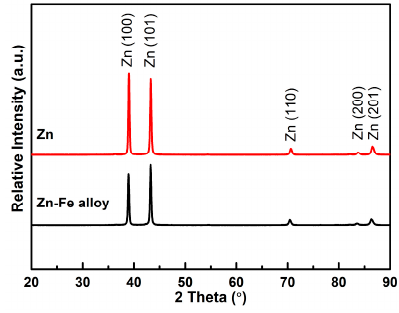
Figure 3. XRD spectra of ZC and